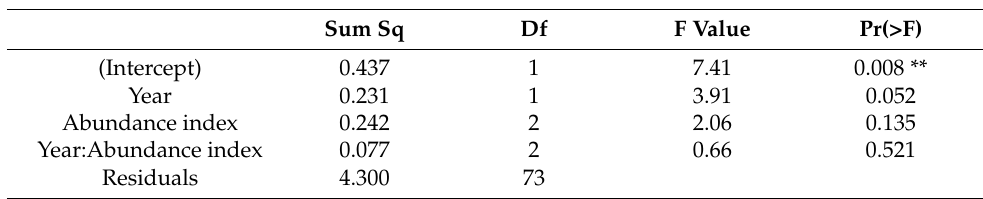
Table 3. ANCOVA results of differences in the direction of the linear models for the abundance indices. The covariate year interaction with the factorial variable abundance index represents the categories of CPUE, LPUE, and RPN. Signif. codes: 0.001 ‘**’ 0.01